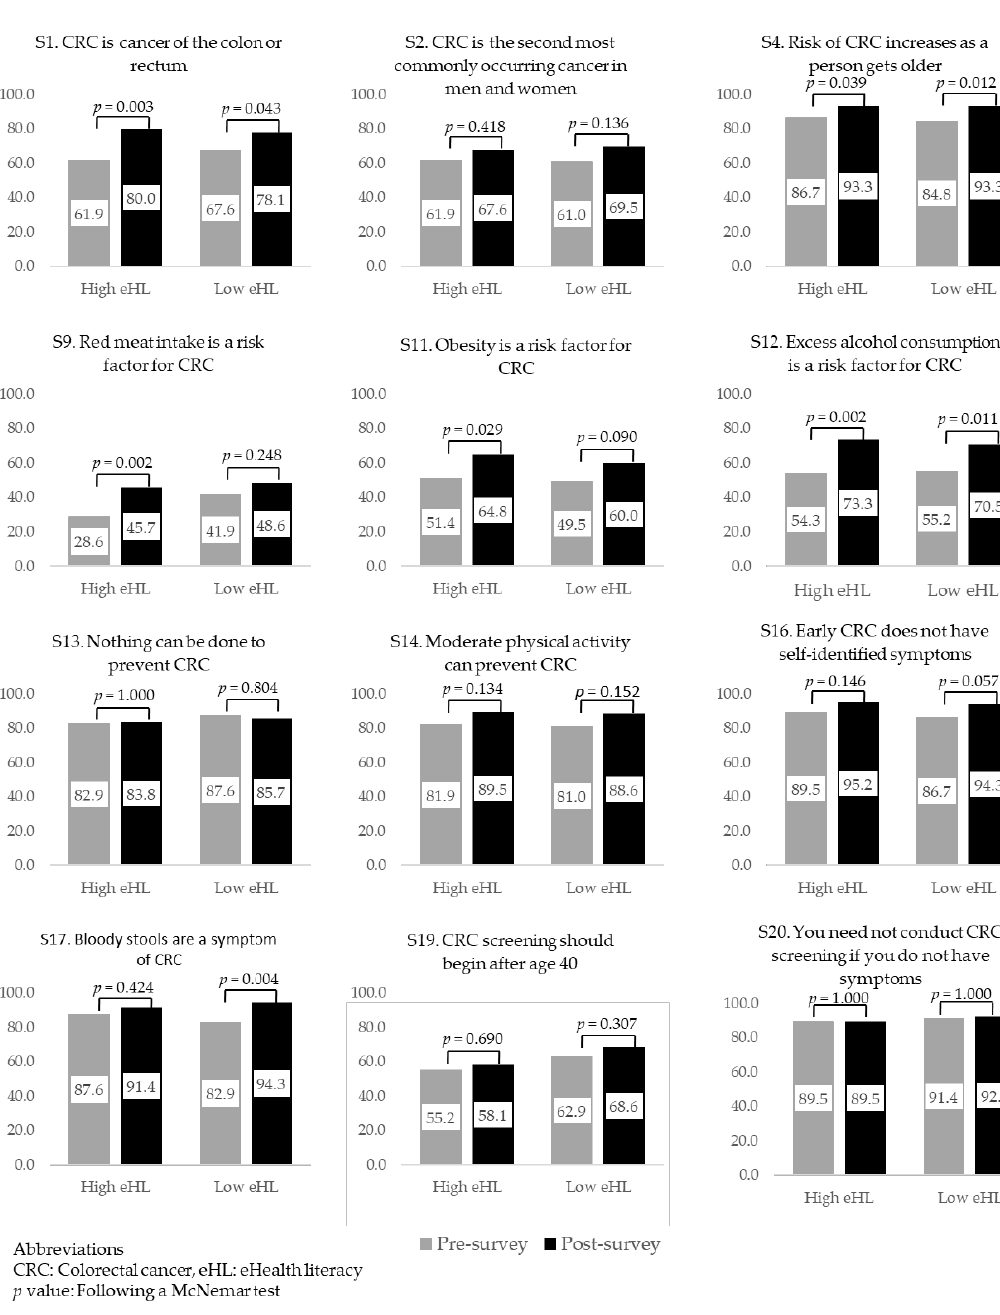
Figure 1. The differences in the proportion of correct responses for colorectal cancer (CRC) knowledge statements between the pre- and post-survey phases in the high and low eHealth literacy (eHL) groups.